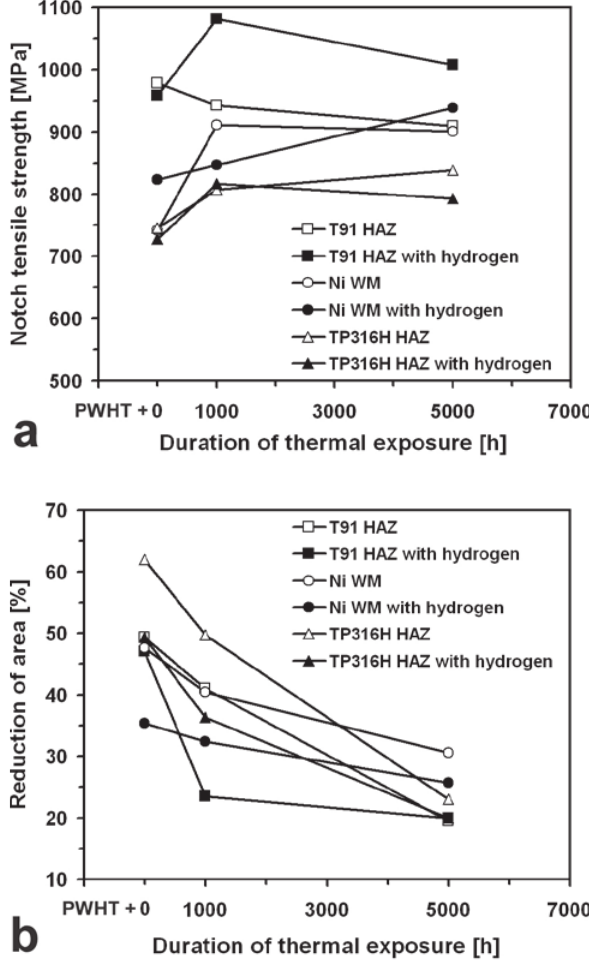
Fig. 4: Notch tensile properties of different microstructural regions of the welded joint T91/TP316H in individual material states with respect to the heat treatment condition and the application of hydrogen charging: notch tensile strength (a), reduction of area